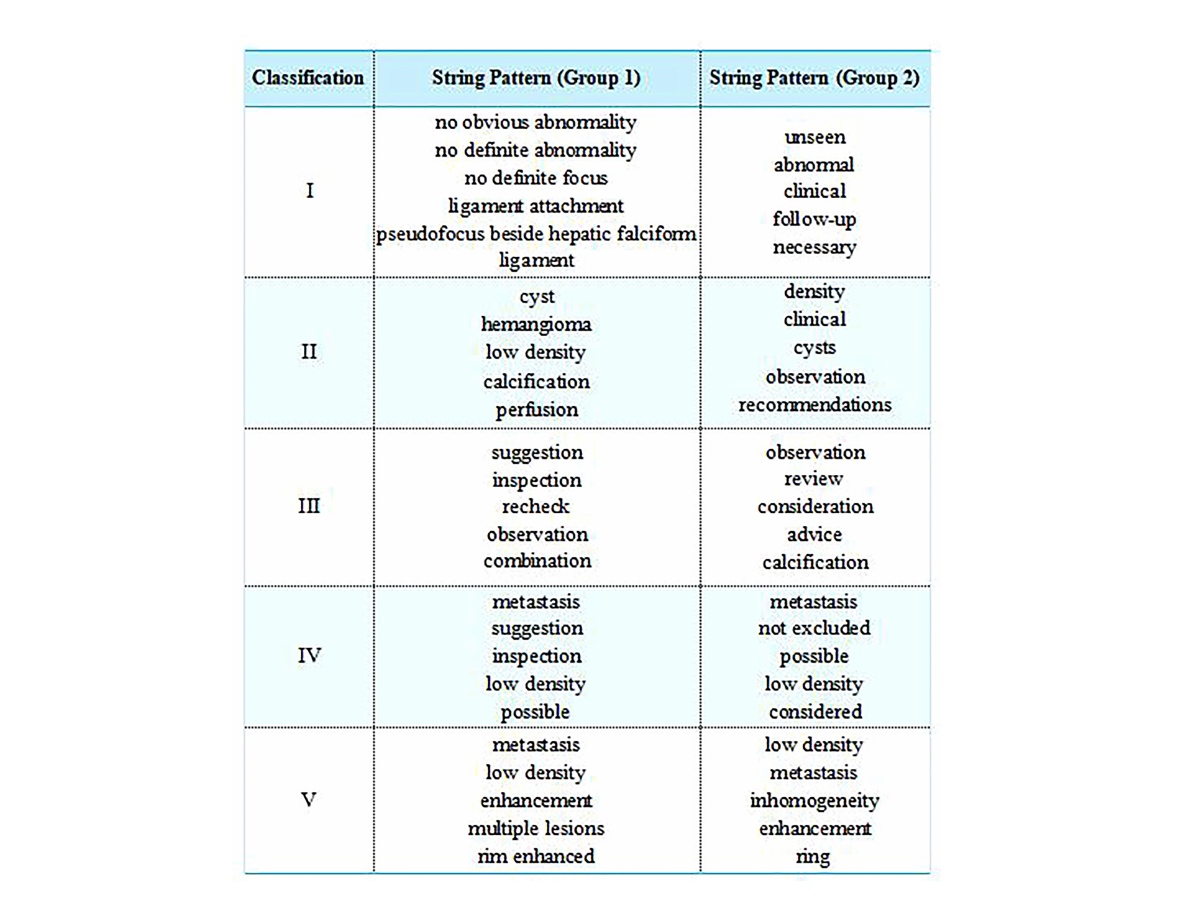
FIGURE 3 The string patterns de fi ned by 3 experienced radiologists (Group I) and calculated by TF-IDF method (Group2). For publication purposes, we provided English version of Chinese words from the imaging